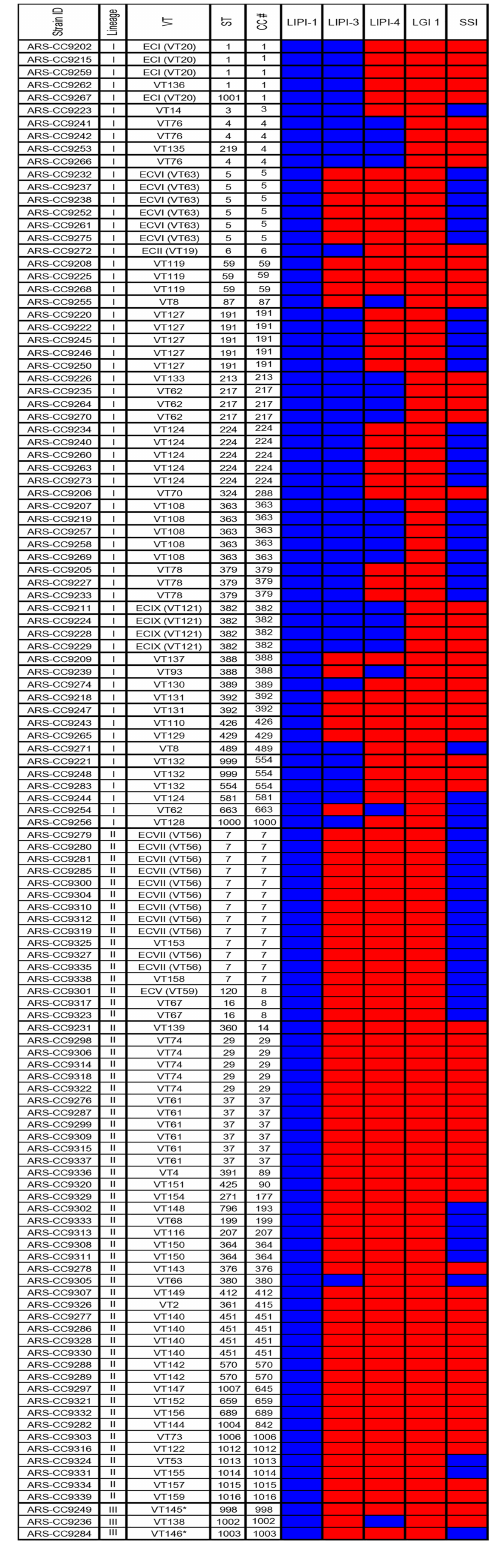
Fig 4. Presence/absence of genomic island and pathogenicity islands identified among the study CCs. Blue = detected. Red = not detected. https://doi.org/10.1371/journal.pone.0197053.g004 PLOS ONE | https://doi.org/10.1371/journal.pone.0197053 May 9,